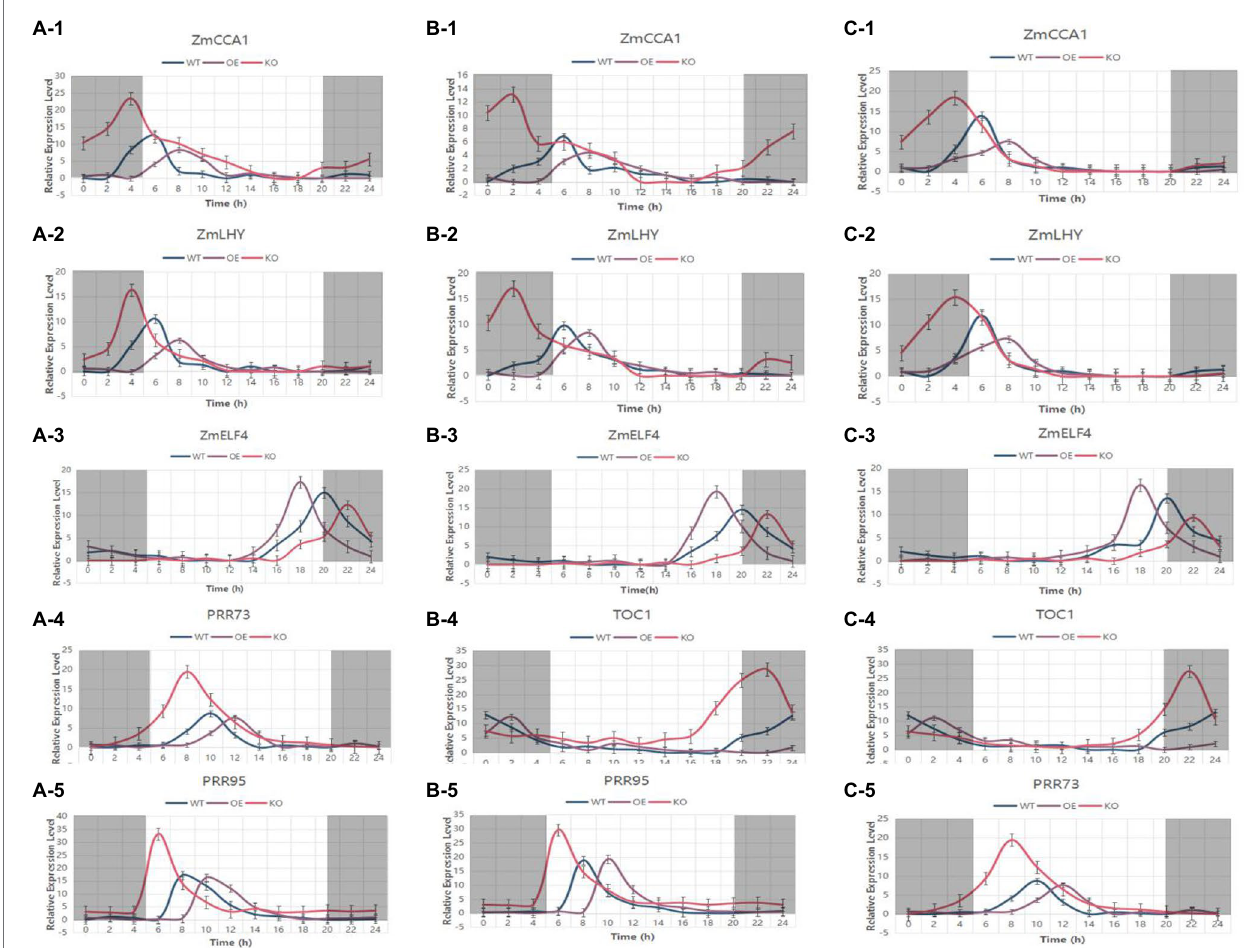
FIGURE 13 | The expression patterns of circadian rhythm genes in transgenic-positive plants and the WT were analyzed under LD light for 24 h. (A–C) represent ZmTOC1, ZmPRR73, and ZmPRR95 transgenic-positive plants, respectively. WTs are plotted in blue, objective gene overexpression-positive plants are plotted in violet, and objective gene knockout-positive plants are plotted in